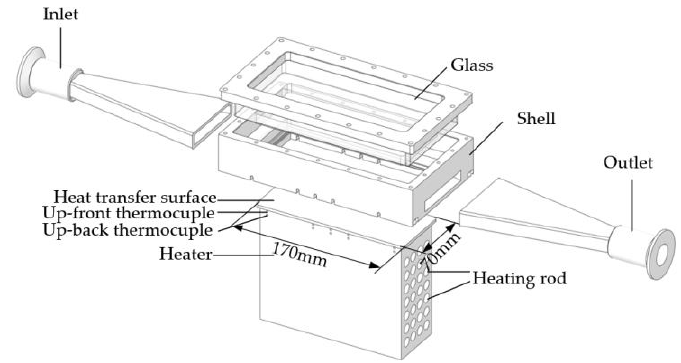
Figure 3. Explosive view of the rectangular coolant channel test section.